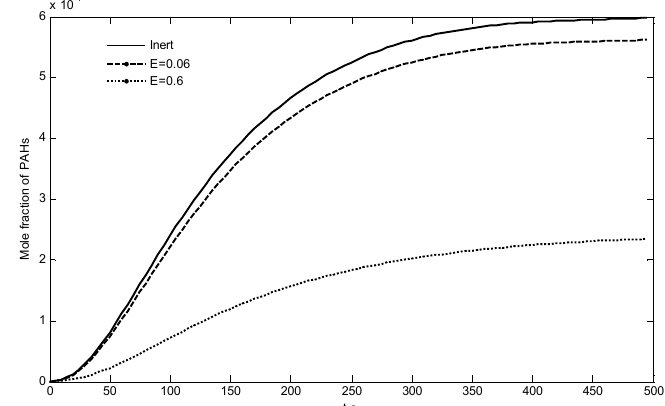
Figure 12. Formation of PAHs predicted by comprehensive kinetic model [33] (data points) and present simplified model (lines ).